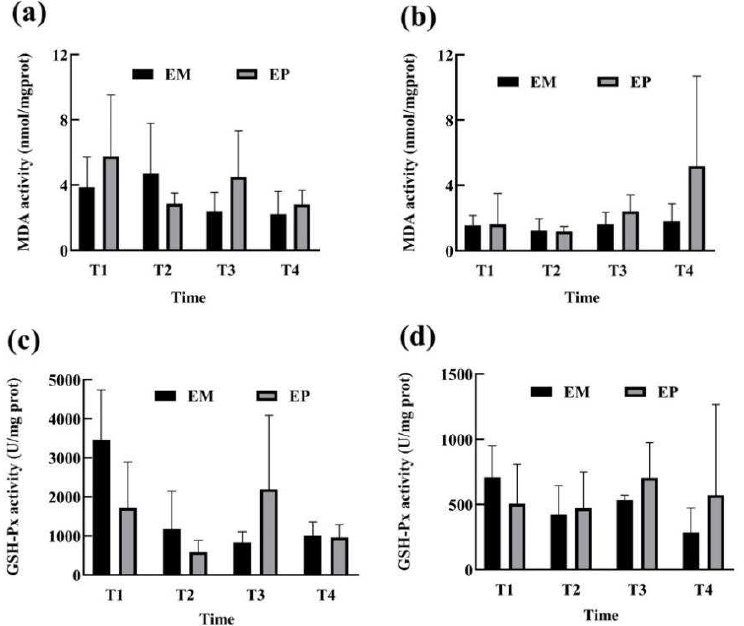
Figure 1. Differences in MDA content in ( a ) female and ( b ) male crabs and differences in GSH-Px activity in ( c ) female and ( d ) male crabs between the EM and EP groups at different time points. Data are means ± SD.